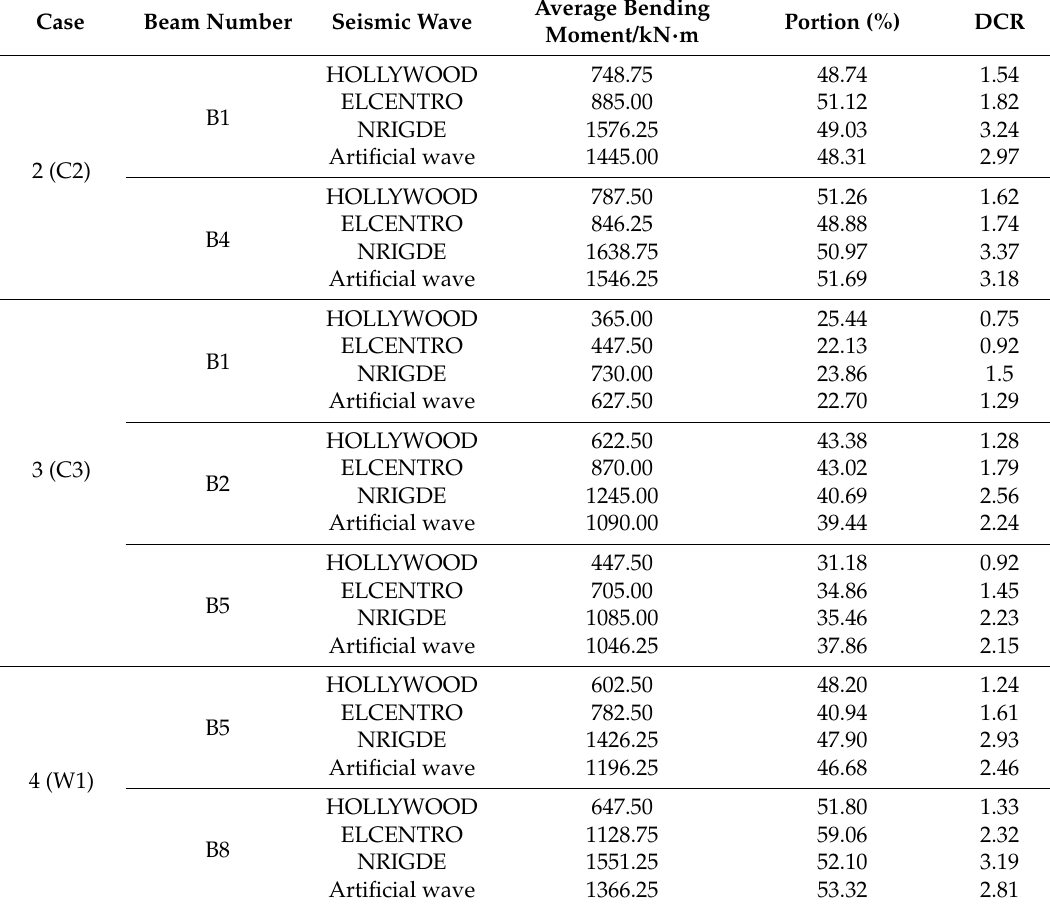
Table 14. Force condition of beams in cases 2, 3, 4 and